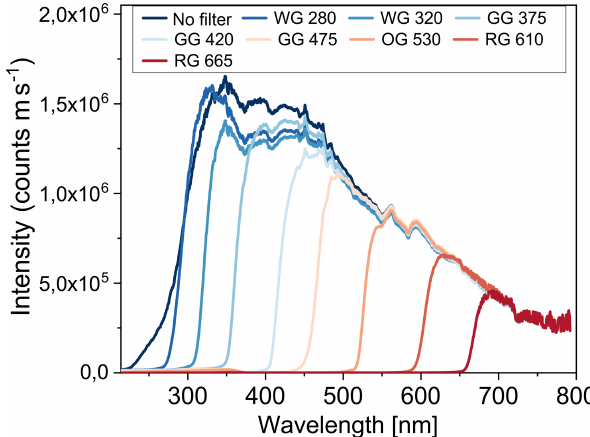
Figure B1. Overview of the bandpass and long-pass glass filters used in the investigation of the spectral origin of spectrometer stray light and their influence on the spectrum of a LDLS. The spectra recorded with a filter were scaled to match the spectrum without a filter in the spectral region between 700 and 800nm. This explains the higher intensities of the WG 280 spectrum compared to the one without a filter. The position of the fibre, with respect to the lens coupling of the radiation from the LDLS into the fibre, was opti- mized for filters in the light path. For the spectrum without a filter this leads to the slightly different spectral shape.